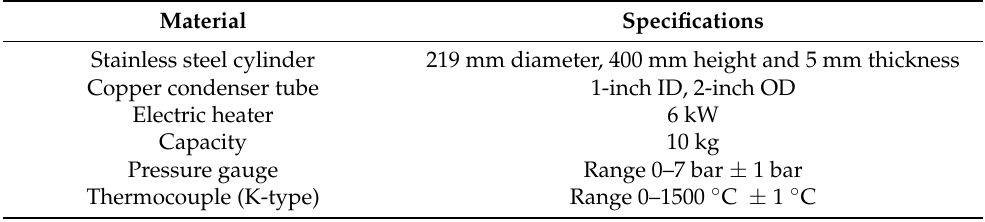
Figure 3. In total,10 kg capacity laboratory scale pyrolysis setup. Figure 3. In total, 10 kg capacity laboratory scale pyrolysis setup. Table 4. Specification of the pyrolysis